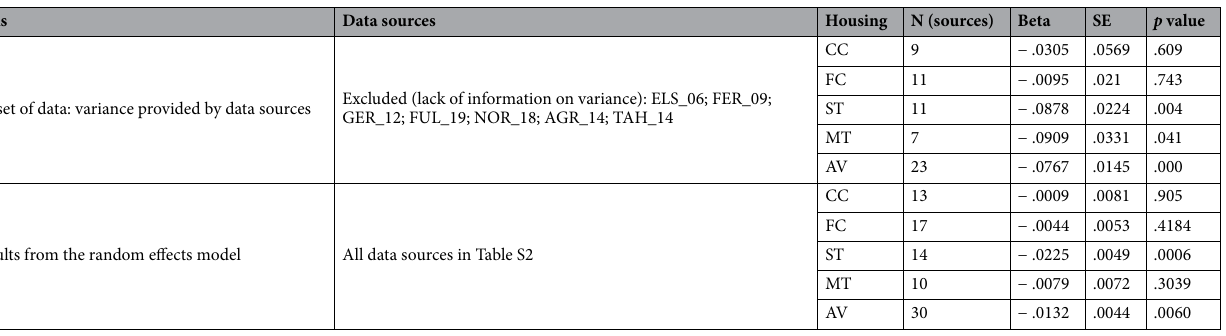
Table 1. Sensitivity Analyses. Meta-regression analyses of cumulative laying hen mortality in different commercially managed indoor housing systems as a function of mid-year of data collection using different meta-analytical models and subsets of the data. Source codes are described in the Supplementary Table S2. CC conventional cages, FC furnished cages, ST single-tier aviaries, MT multi-tier aviaries, AV indoor aviary (all